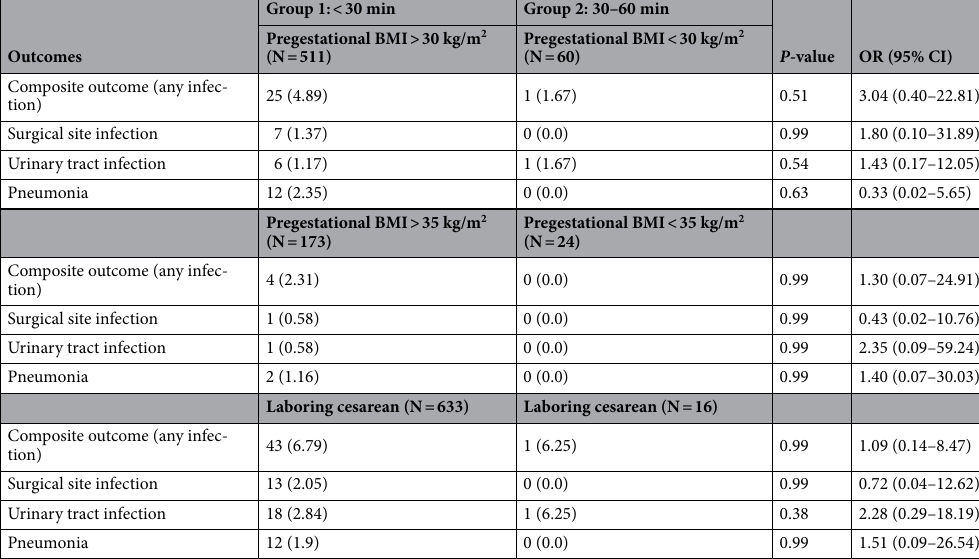
Table 4. Infectious morbidity in obese women and intrapartum cesareans according to timing of antibiotic prophylaxis before skin incision. Data are mean ± standard deviation (median) or N (%) unless otherwise